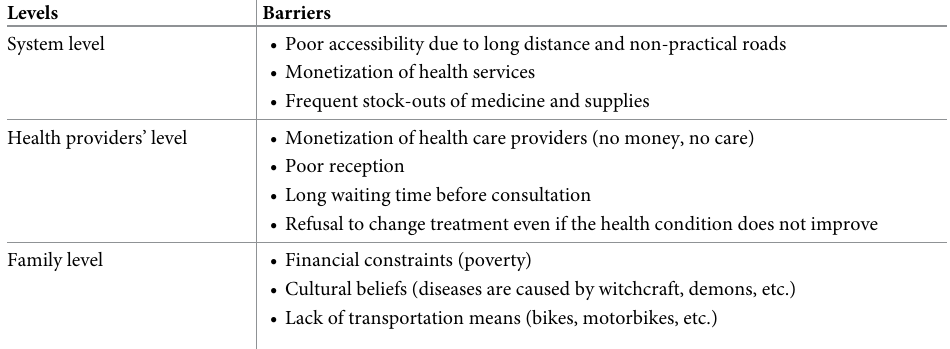
Table 2. Major themes of the barriers to healthcare seeking for young infants with PSBI identified during focus group discussions and